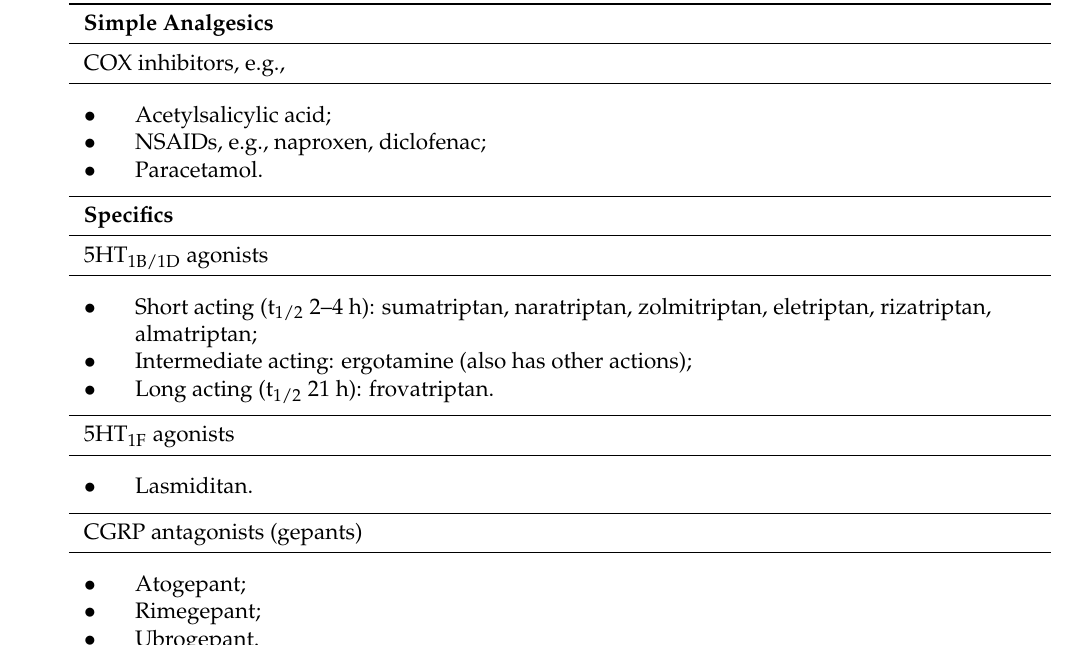
Table 1. Drugs used to treat migraine headache